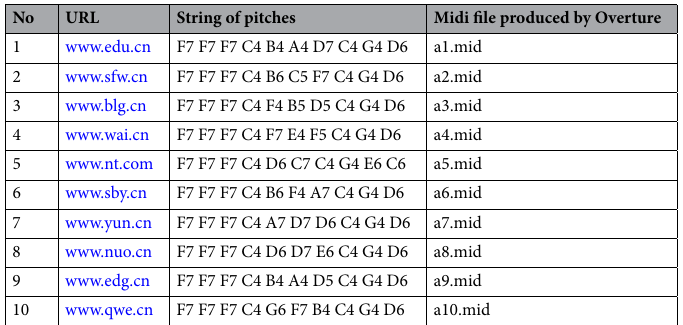
No URL String of pitches Midi file produced by Overture